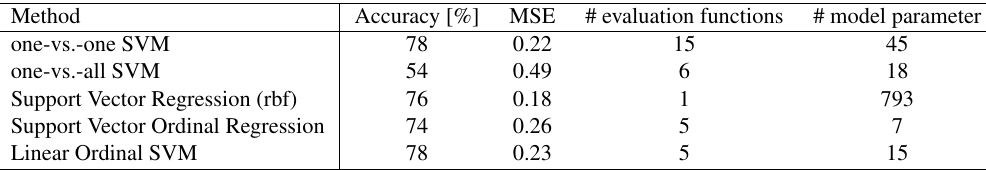
Table 2: Performance overview on the simulated data set